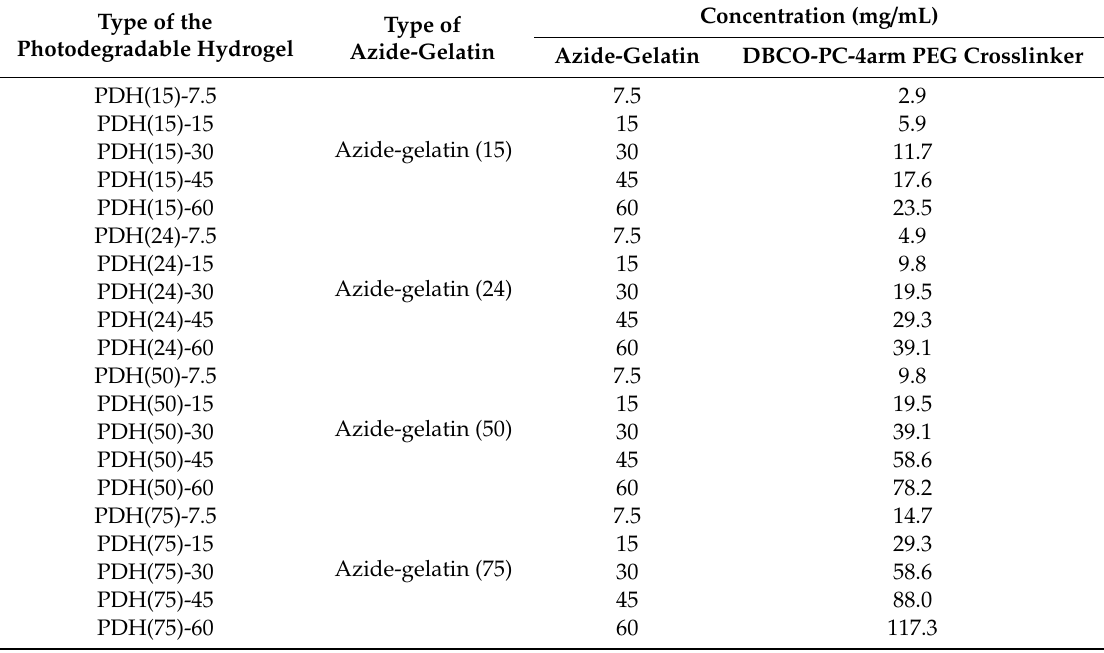
Table 1. Composition of the photodegradable